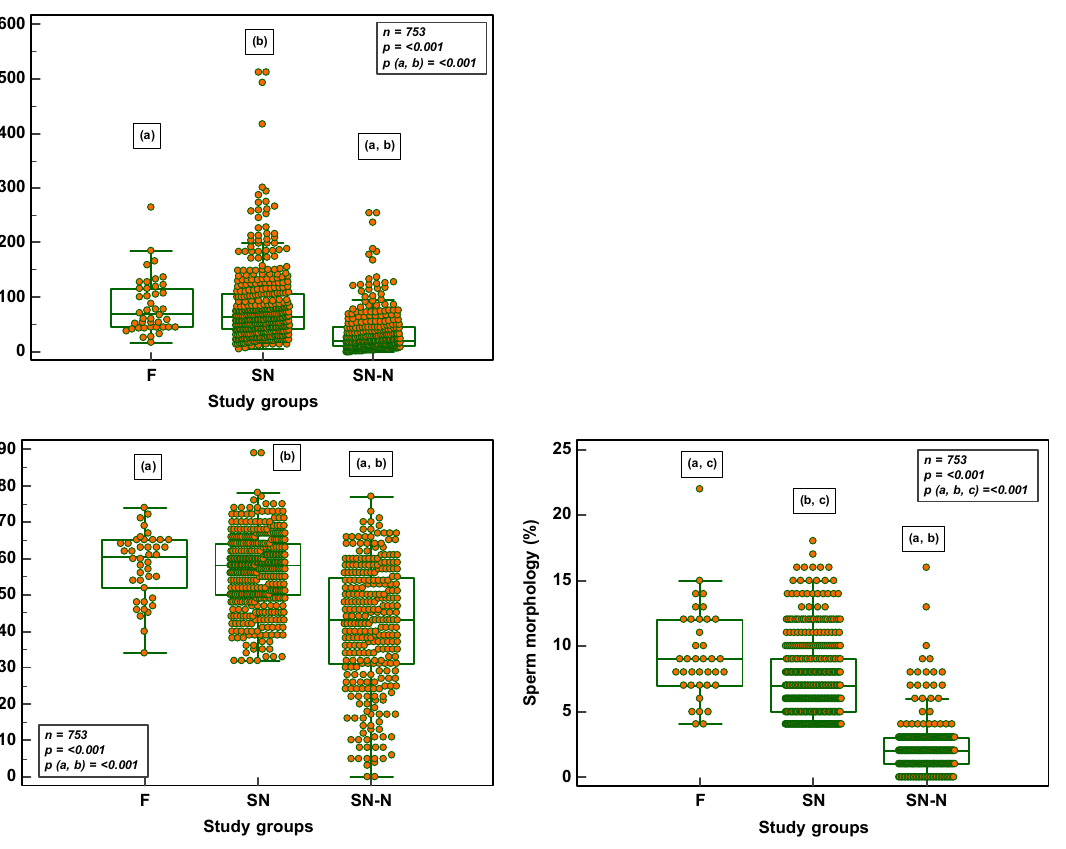
Figure 3. Scatter diagram with regression line between SDF parameters and semen parameters. Total SDF did not differ significantly ( p = 0.416) whether the semen samples were from an F (8.1 ± 5.8; n = 42), SN (11.7 ± 7.8; n = 416) or SN-N (12.2 ± 10.2; n = 295) study group. The same was also the case ( p = 0.688) in the vital SDF fractions (F = 1.3 ± 1.4; SN =